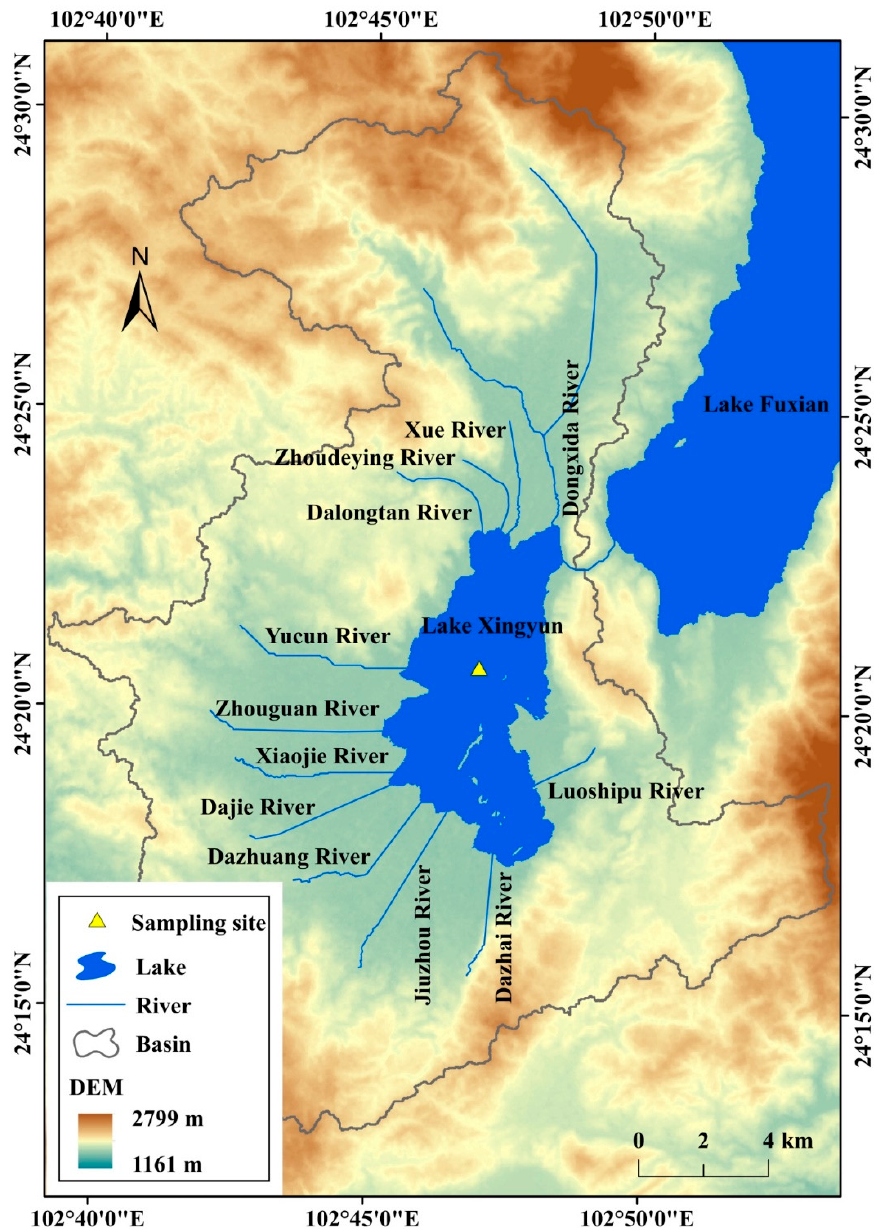
Figure 1. Map of Lake Xingyun catchment with the 12 main tributaries and the sampling site for lake water.